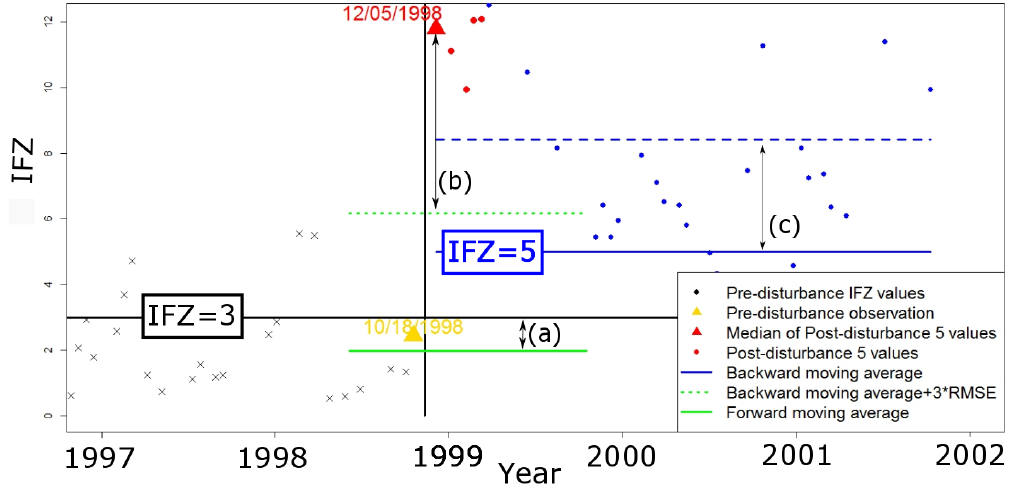
Figure 2. Change in time series Integrated Forest z-score (IFZ) values (Lat: 32.097°, Lon: −84.844°).